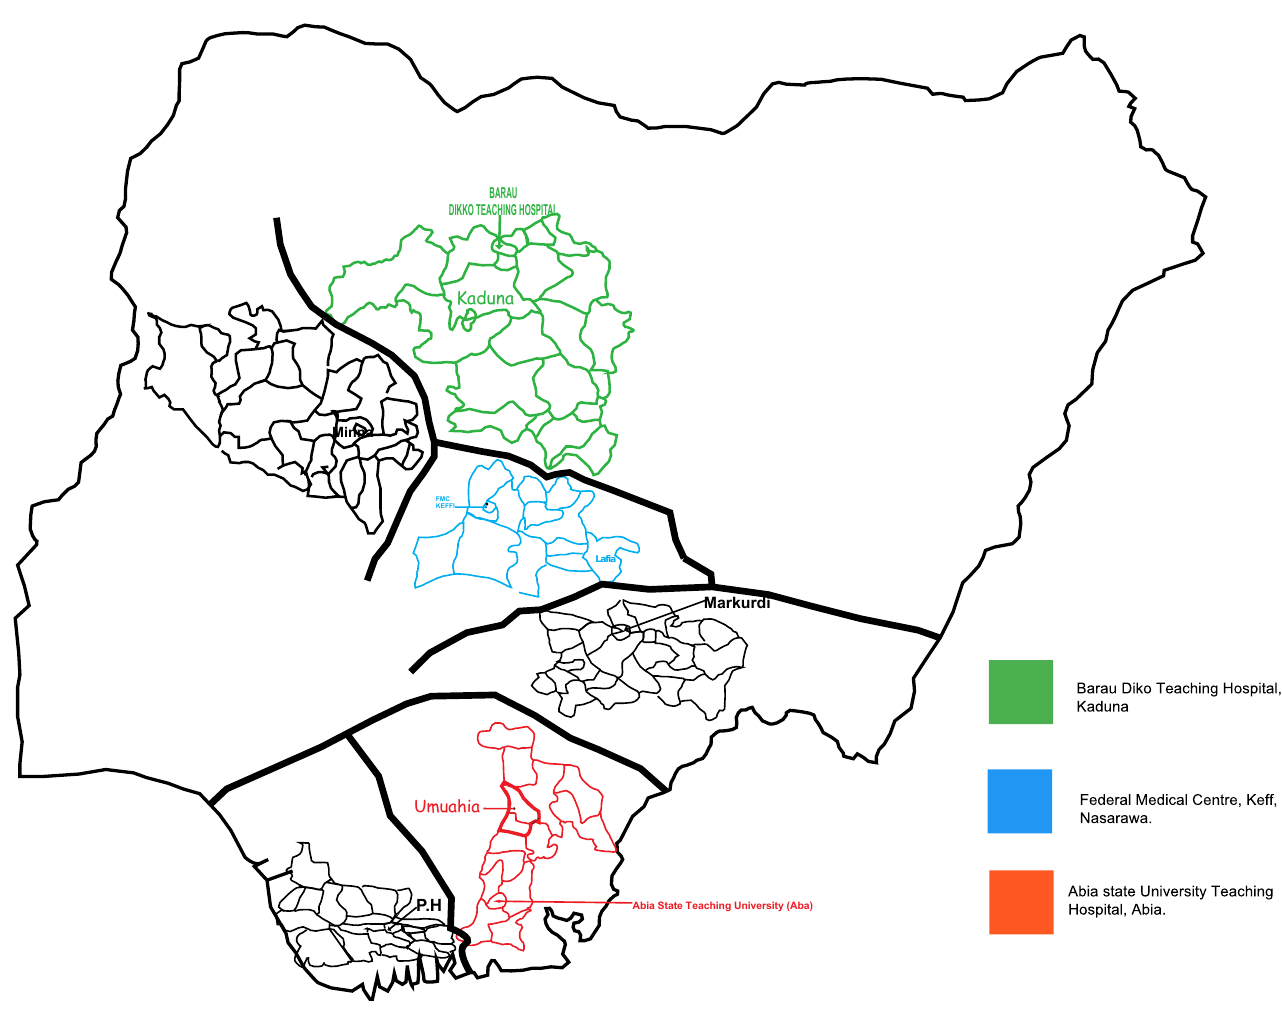
Figure 1. Arboviral and malaria study sites in Nigeria.